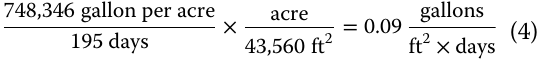
Table 1 Water demand comparison between Cannabis and commodity crops